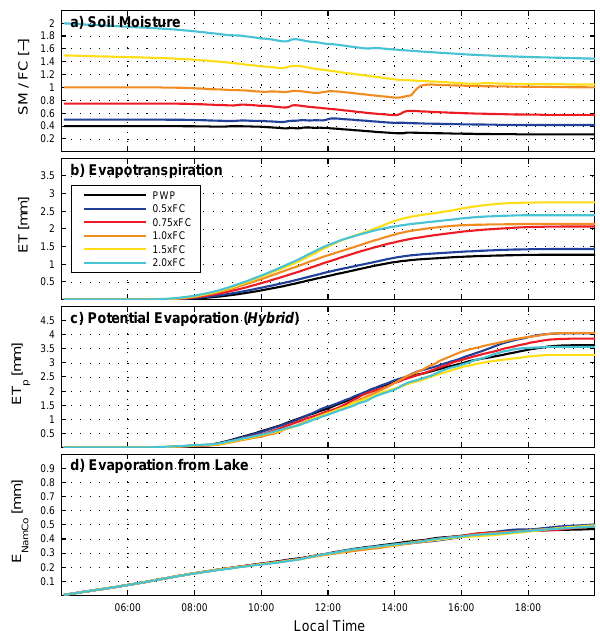
Figure 6. Moisture variables over time and averaged for Nam Co Basin for cases PWP, 0.5 × FC, 0.75 × FC, 1.0 × FC, 1.5 × FC and 2.0 × FC on 17 July 2012: (a) soil moisture in terms of FC [–]; (b) integrated evapotranspiration [mm]; (c) integrated poten- tial evaporation [mm] and (d) integrated evaporation from Nam Co Lake